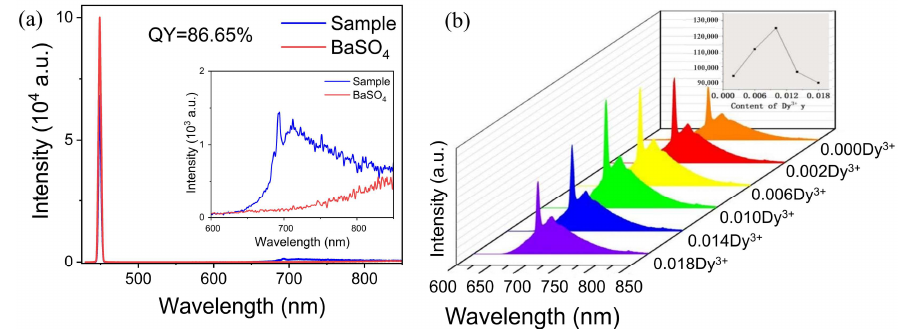
Figure 4. ( a ) Normalized spectra of the 450 nm light with BaSO 4 as reference for quantum efficiency measurement and of GAGG:0.1Cr 3+ ,0.01Dy 3+ ; ( b ) emission spectra (λ ex = 450 nm) of GAGG:0.1Cr 3+ , y Dy 3+ ( y = 0, 0.002, 0.006, 0.01, 0.014, 0.018).